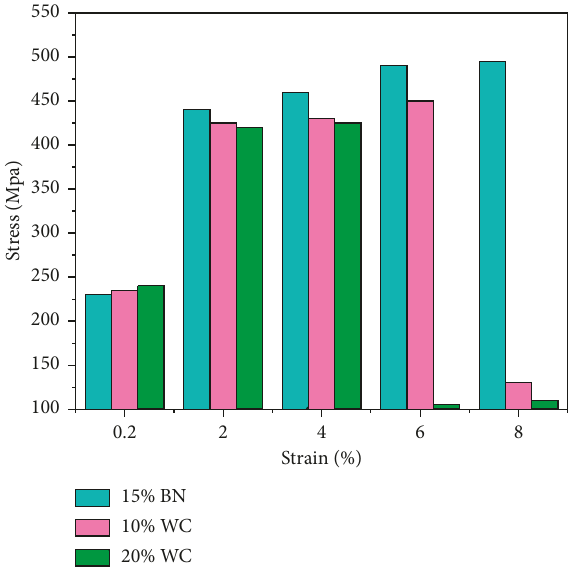
Figure 4: Stress-strain plots for all the three tested composites under T4 heat